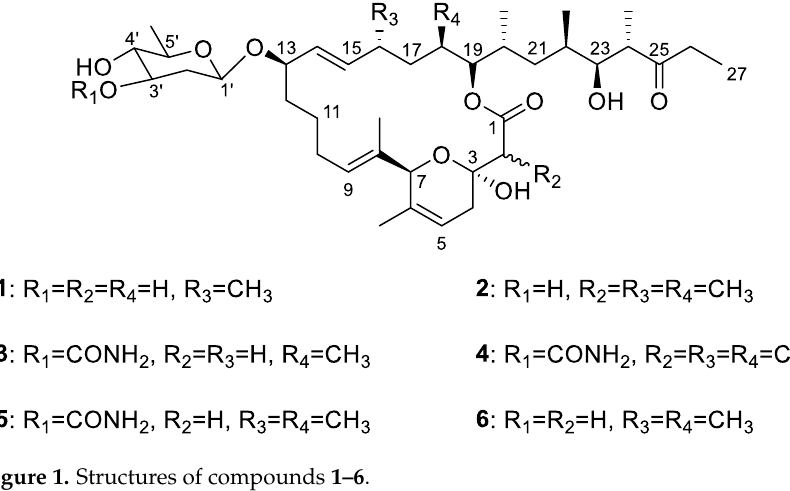
Figure 1. Structures of compounds 1 – 6.